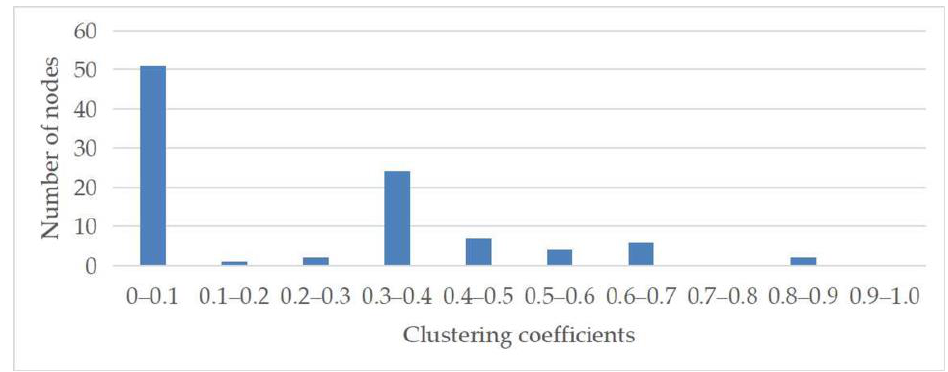
Figure 4. Clustering coefficients of traffic complex network.